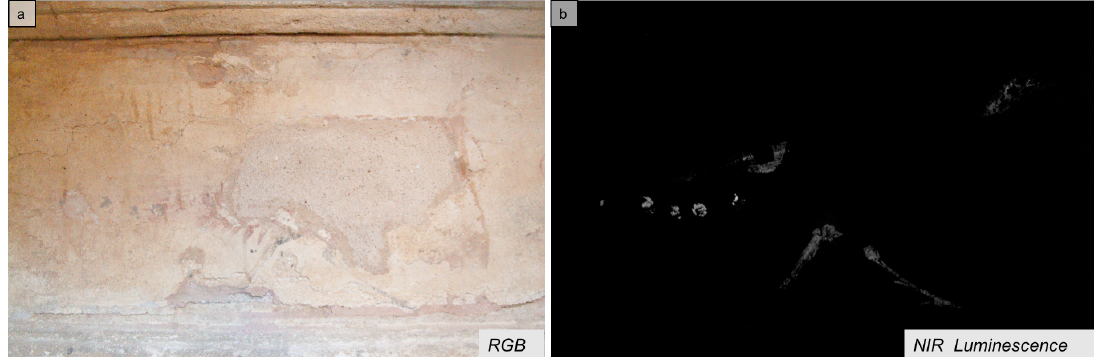
Figure 24. ( a ) A color (RGB) image of a partridge painted on the dado of the central arcosolium (J); ( b ) The NIR luminescence image identifying the blue dots on the tail as Egyptian blue and providing recovery of the leg, tail, and head details that have disappeared due to deterioration. At the north end of the dado, a smaller bird in grey-blue hue was only partially visible. The center